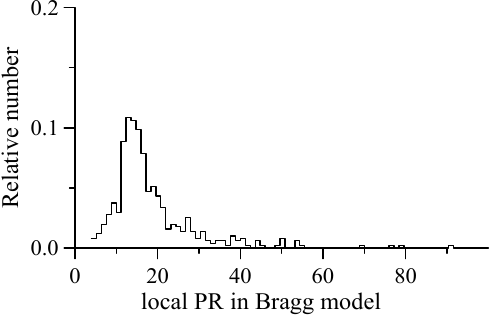
Remote Sens. 2020 , 12 , x FOR PEER REVIEW 13 of 18 Figure 10. Histogram of local values of the PR in the Bragg model for the case shown in Figure 5. Figure 10. Histogram of local values of the PR in the Bragg model for the case shown in Figure 5. Figure 10. Histogram of local values of the PR in the Bragg model for the case shown in Figure 5.